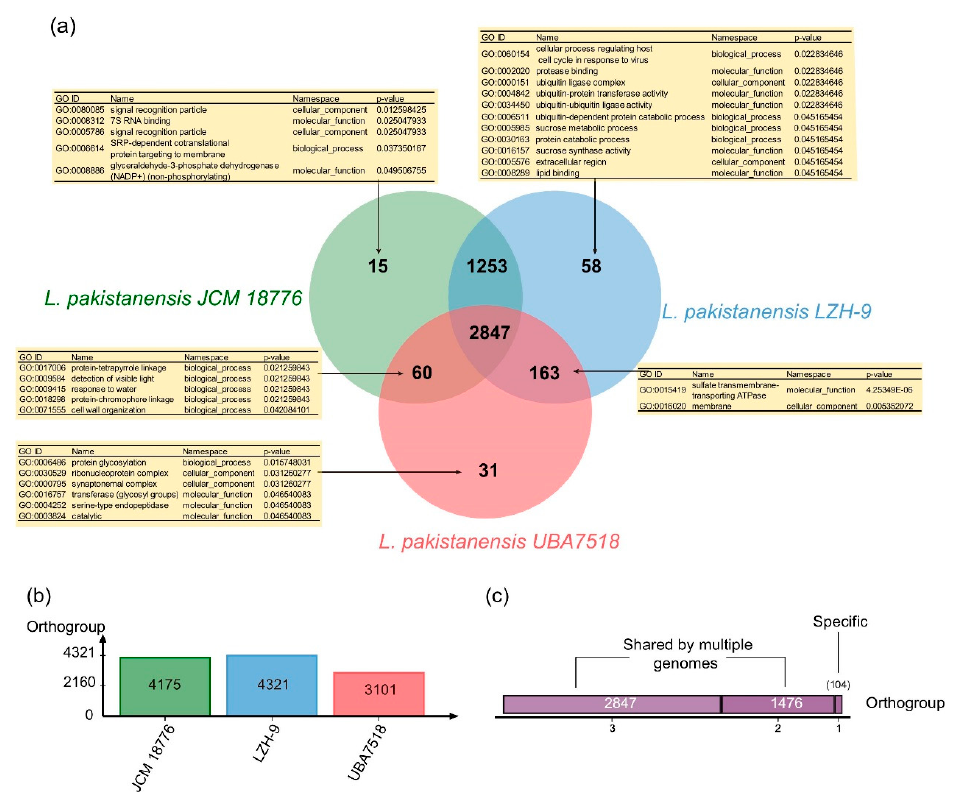
Figure 4. ( a ) Venn diagram showing the numbers of orthogroup including the core genome (shared by three strains of L. pakistanensis ), the accessory genome (shared by some but not at all of these strains) and strain-specific gene families in individual genomes; enriched Gene ontology (GO) terms ( p < 0.05) in respective orthogroups are shown in the tables. ( b ) Bar chart showing the total numbers of orthogroup identified in each genome of the three strains of L. pakistanensis . ( c ) The total numbers of orthogroups of strain-specific gene families (=1) or the accessory genome (shared by two, three strains) and core genome of three strains of L. pakistanensis .